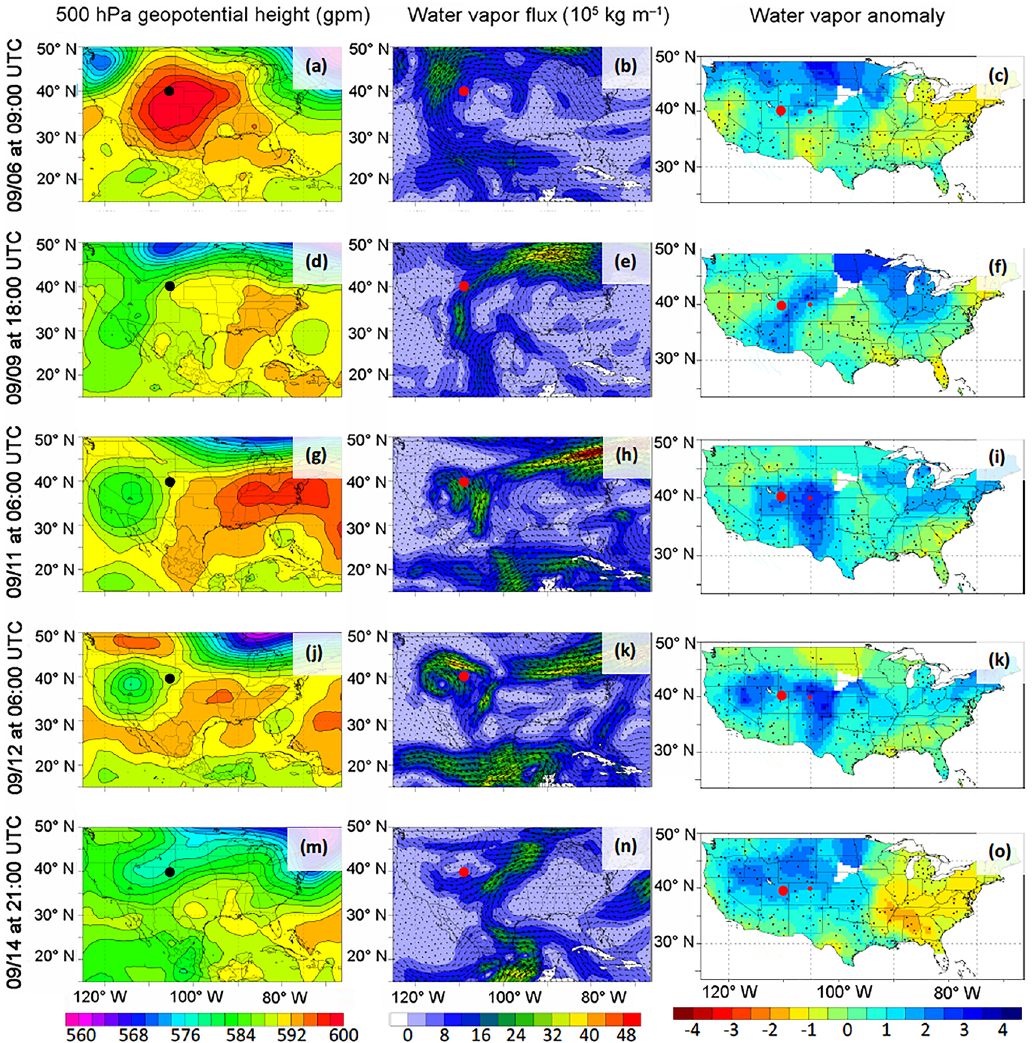
Figure 8. A comparison of NARR 3-hourly averaged 500hPa geopotential height (a, d, g, j, m) , NARR 3-hourly averaged integrated water vapor flux (b, e, h, k, n) , and SuomiNet gridded standardized PW anomalies (c, f, i, k, o) . Each row represents a different time surrounding the 2013